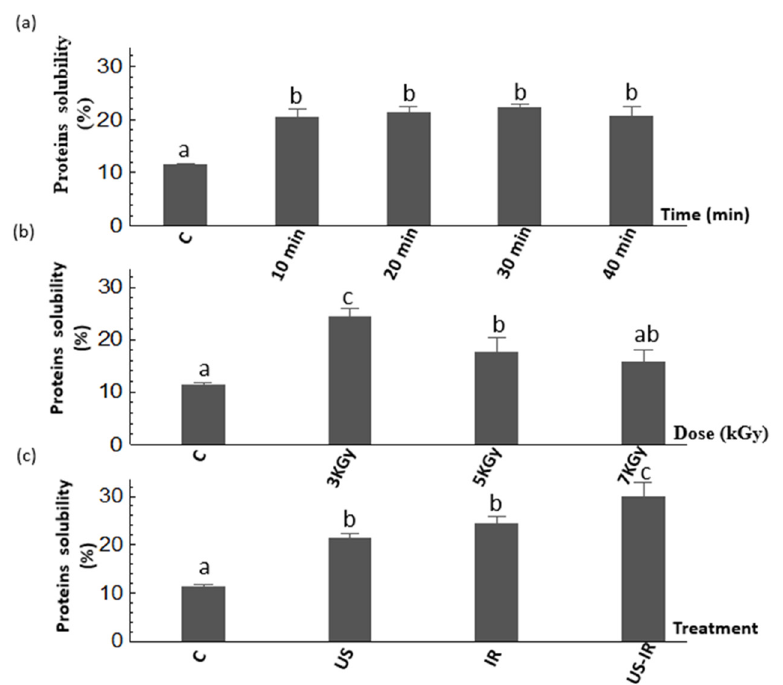
Figure 1. Solubility of cricket proteins in untreated samples (C), samples treated by ultrasound (US) at increasing times (10, 20, 30 and 40 min) ( a ), by γ -irradiation (IR) at increasing doses (3, 5 and 7 kGy) ( b ), and by combined ultrasound-assisted γ -irradiation (US-IR; 20 min; 3 kGy) ( c ). Different letters above the bars indicate significant differences among the mean values of the samples ( p ≤ 0.05). Data shown is the mean ± SD ( n = 3).